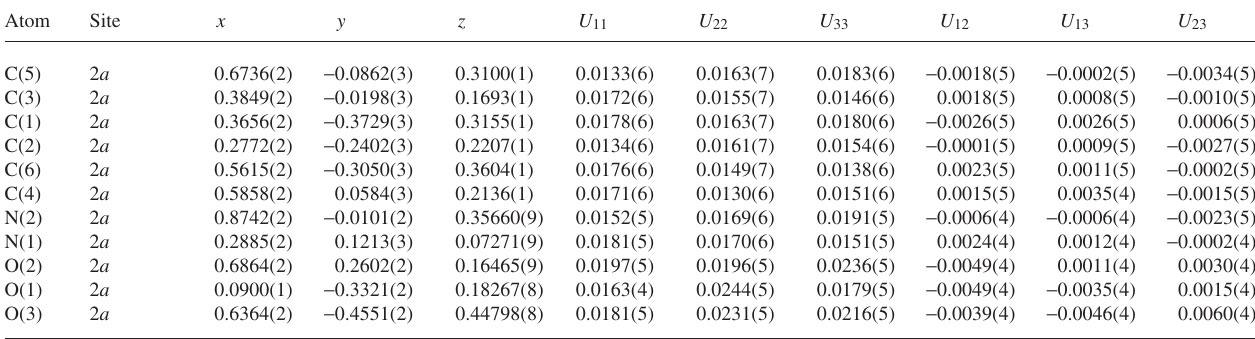
Table 3. Atomic coordinates and displacement parameters (in Å 2 )